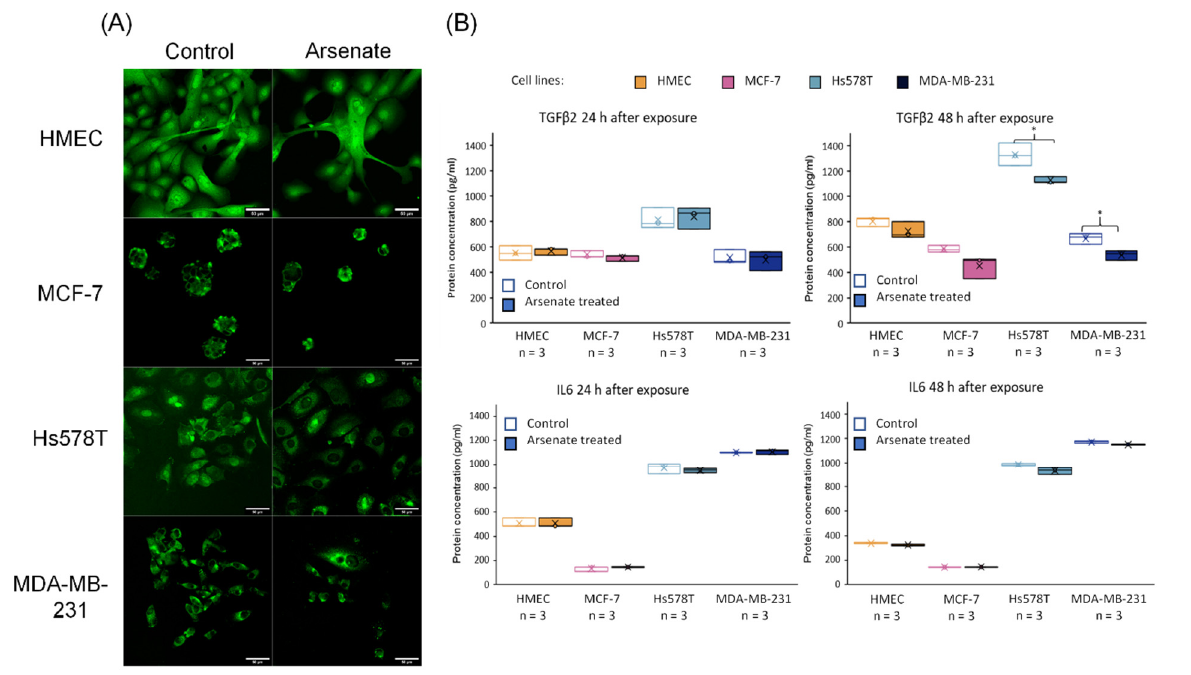
Figure 8. ( A ) Microscopy visualization of BCL2 validation at the protein level. Protein expression of BCL2 marked by fluorescently tagged antibodies followed by confocal microscopy evaluation. It can be seen that the expression level of the BCL2 protein is slightly reduced in case of the arsenate treated group compared to control for the case of Hs578T and MDA-MB-231 at 48-h post-treatment, confirming the qRT-PCR and microarray data. ( B ) TGF β 2 and IL6 validation at the protein level. Protein expression of TGF β 2 and IL6 released in cell culture medium 24 h and 48 h for control and arsenate treated cells (HMEC, MCF-7, Hs578T and MDA-MB-231) evaluated by ELISA. x is the mean and median is the middle line in the boxplots. * p < 0.05 two-sided t -test. TGF β 2 is downregulated in protein level after 48 h of arsenate treated cells, but there is no change in the IL6 levels.